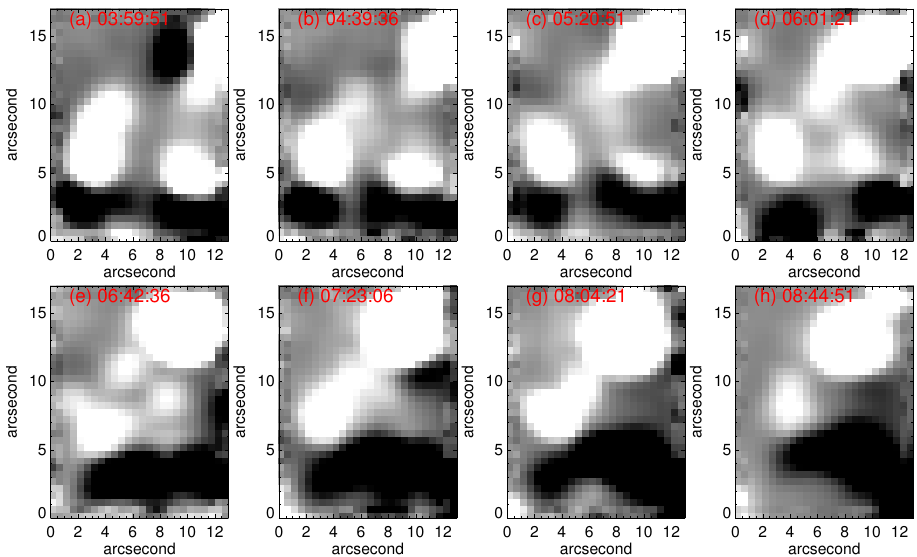
Figure 8. ( a )–( h ) line of sight magnetic field. This figure shows the dynamic evolution of the magnetic field in the core region, which is indicated by white box in Figure 7d. The Non-linear Force Free magnetic Field (NLFFF) extrapolation from the